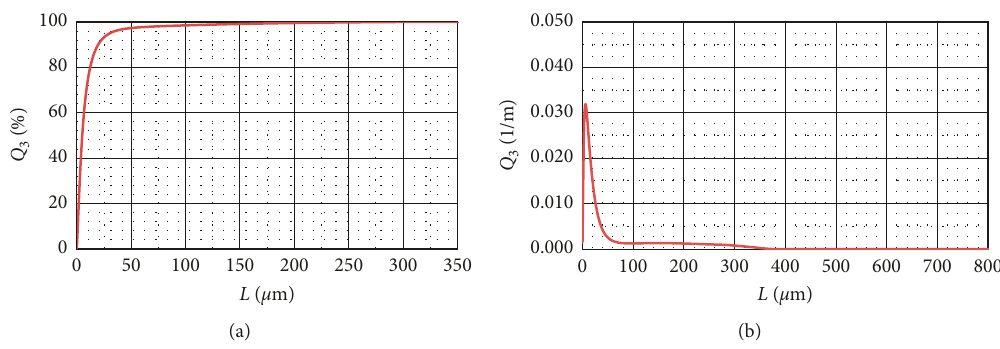
Figure 10: Particle distributions obtained by the use of Kenics static mixer for Re